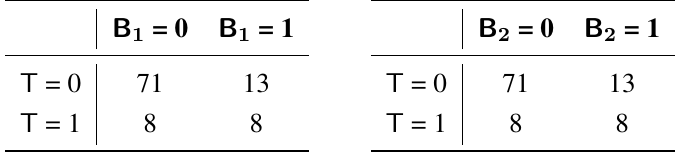
and B , respectively, of dataset DFQR . 1 2